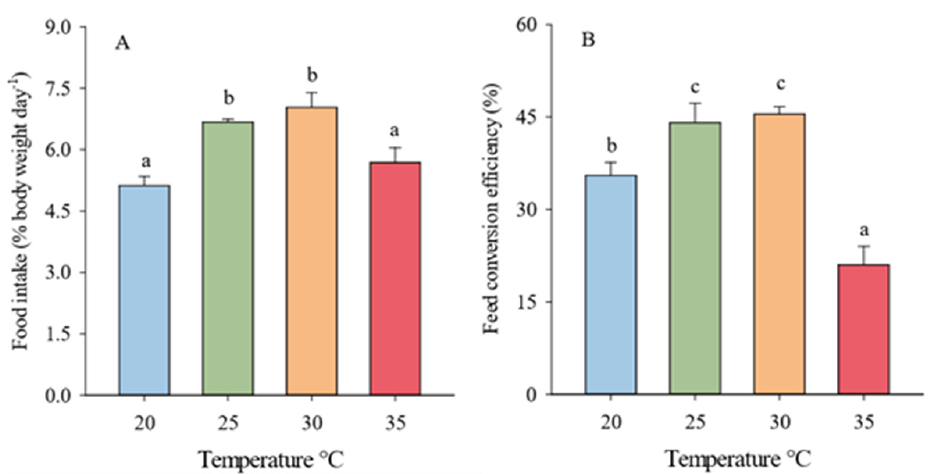
Figure 4. Effects of different temperatures (20-35 °C) on the average daily food intake ( A ) and feed conversion efficiency ( B ) of juvenile mud crabs. Values are expressed as mean ± SD ( n = 3). Different superscripts indicate significant differences between treatments ( p < 0.05).